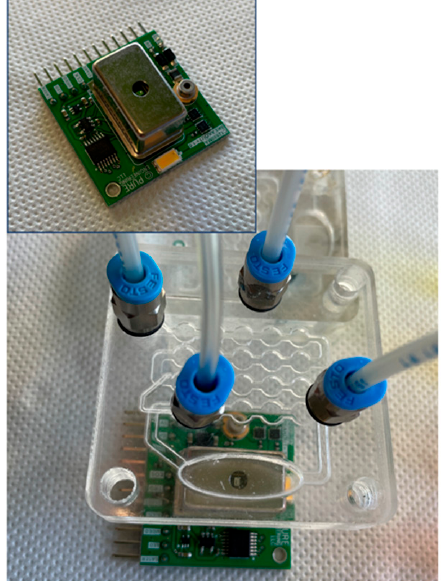
Figure 2. Picture of the microfluidic chip and spectrophotometer. The input slit of the spectropho- tometer is in contact with the portion of the chip immediately above the measurement well. A close view of the C12666MA spectrophotometer is shown in the